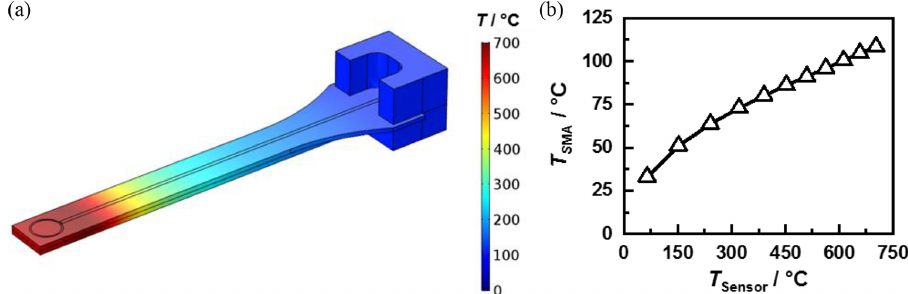
Figure 7. (a) Simulated temperature distribution at a sensor temperature of approx. 700 ◦ C. (b) Simulated temperature of the SMA connector T SMA depending on the temperature of the sensitive layer T Sensor .